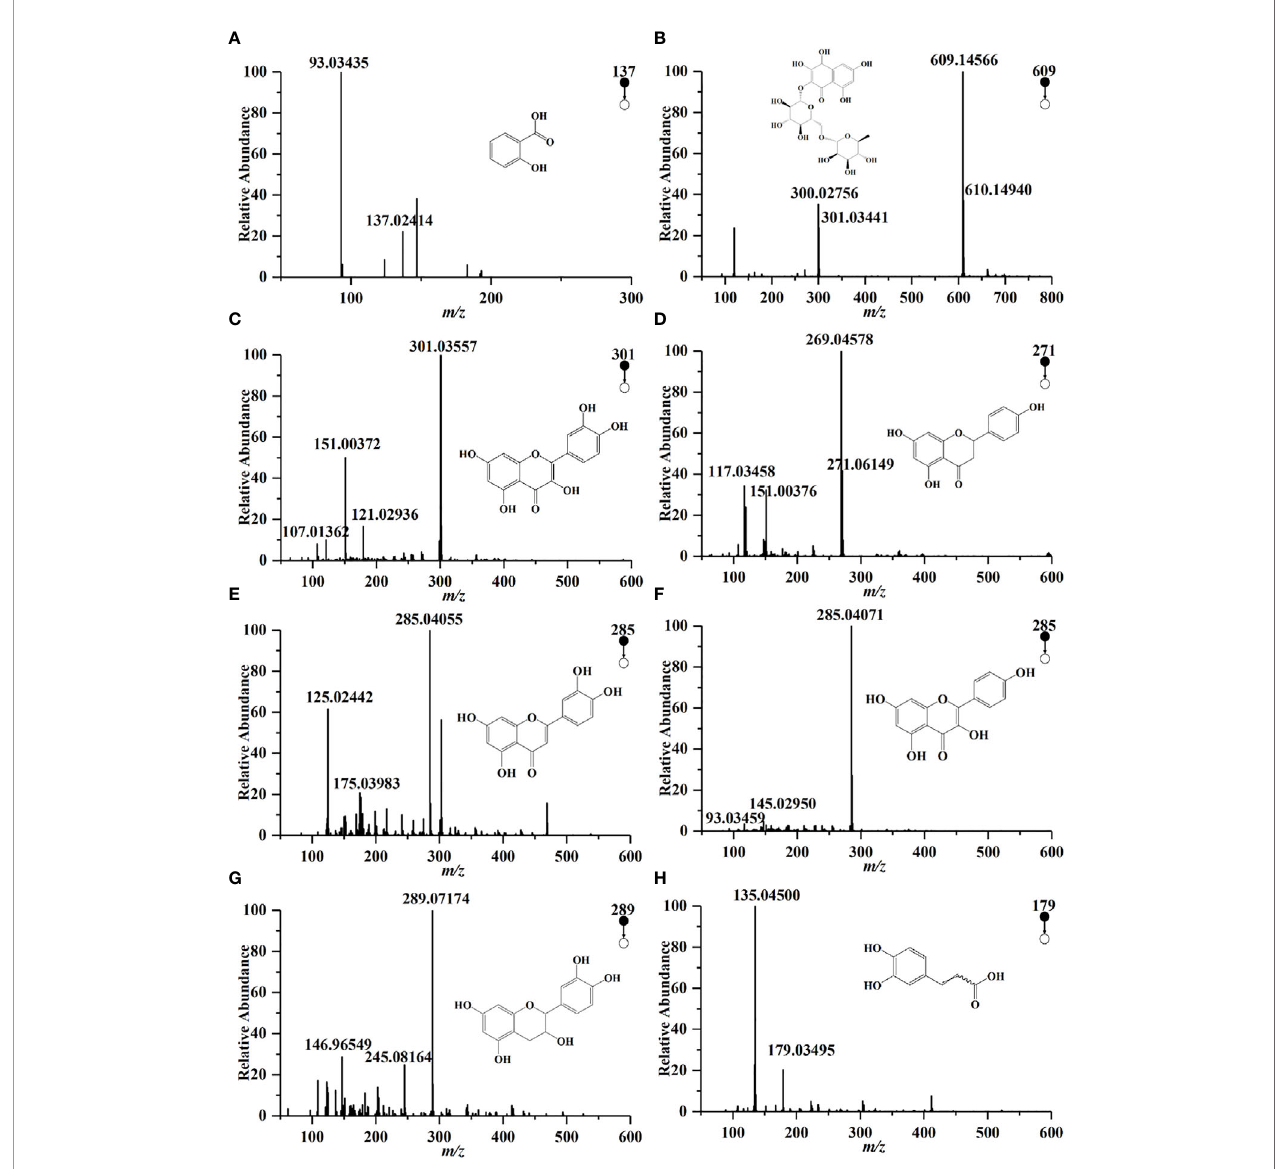
FIGURE 1 | UPLC-Q/TOF-MS spectra of some polyphenols in HCT in negative ion pattern: (A) salicylic acid; (B) rutin; (C) quercetin; (D) narigenin; (E) luteolin; (F) kaemperol; (G) epicatedin; (H) caffeic